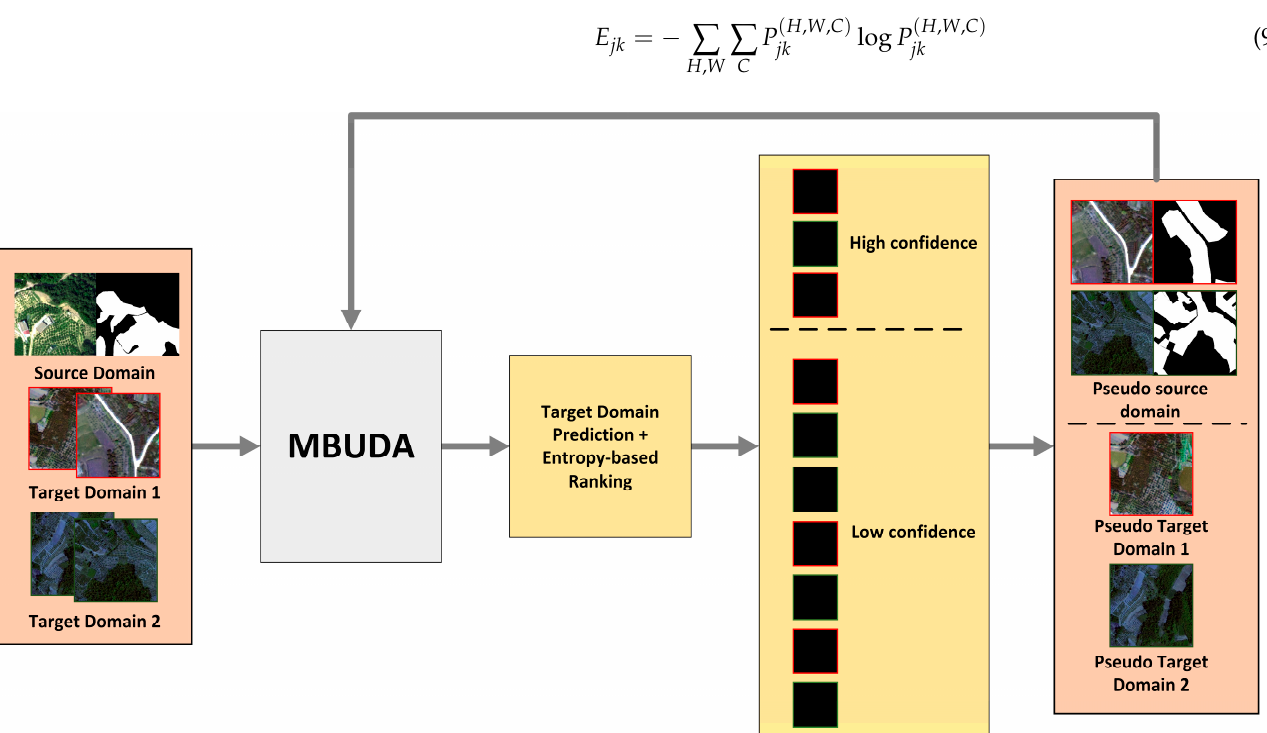
Figure 4. The overall framework of the adaptation enhanced learning strategy.